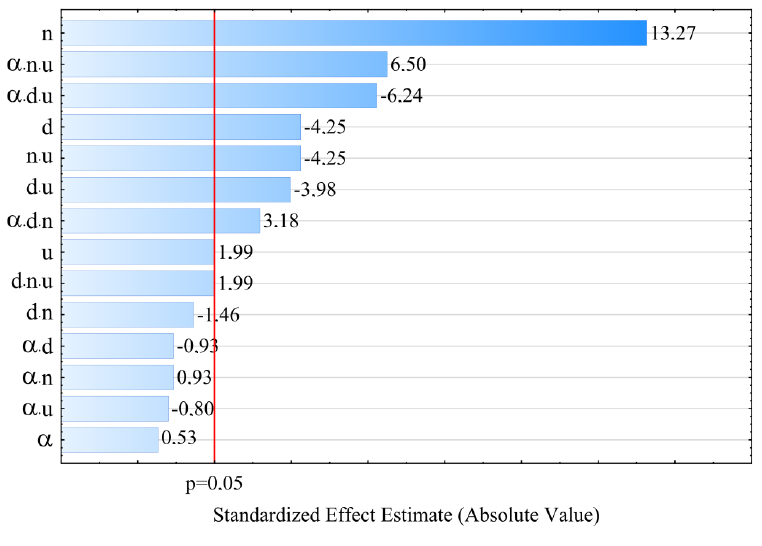
Figure 4. Pareto plots of the standardized e ff ects of empirical model MFR, the vertical line in the plot Polymers 2019 , 11 , 1460 corresponds to the arbitrarily chosen level of significance (p = 0.05).